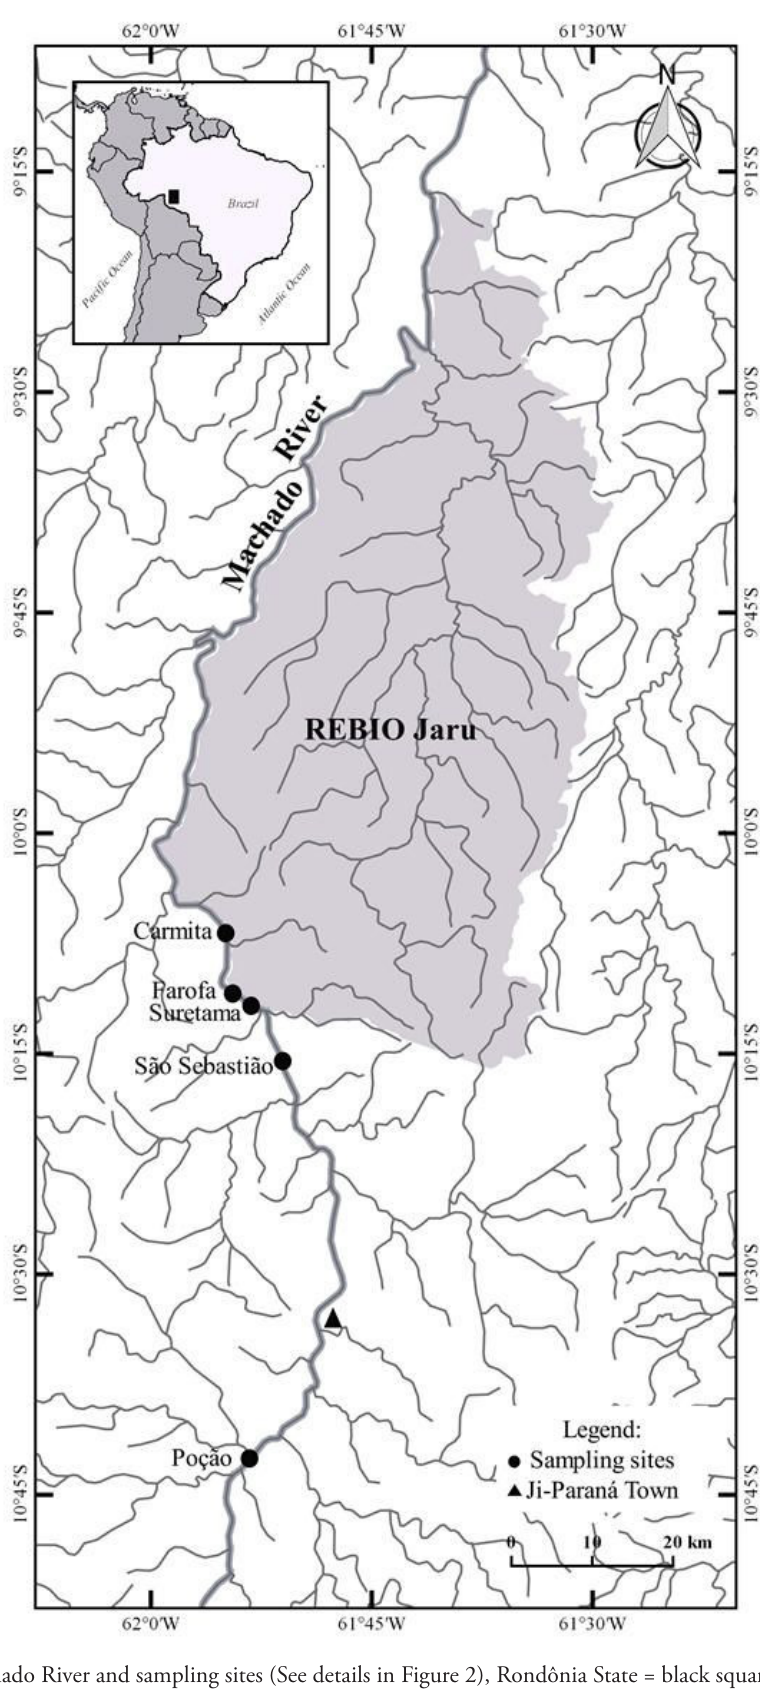
Figure 1. Machado River and sampling sites (See details in Figure 2), Rondônia State = black square,